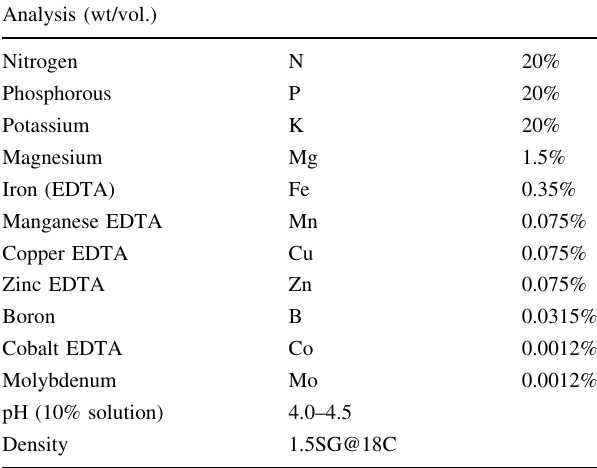
Table 1 Nutrient composition of foliar fertilizer (Boost Xtra) Analysis (wt/vol.)